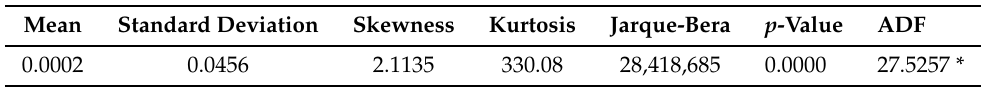
Figure 4. Average daily price of garlic. Table 3. Descriptive statistics and ADF test